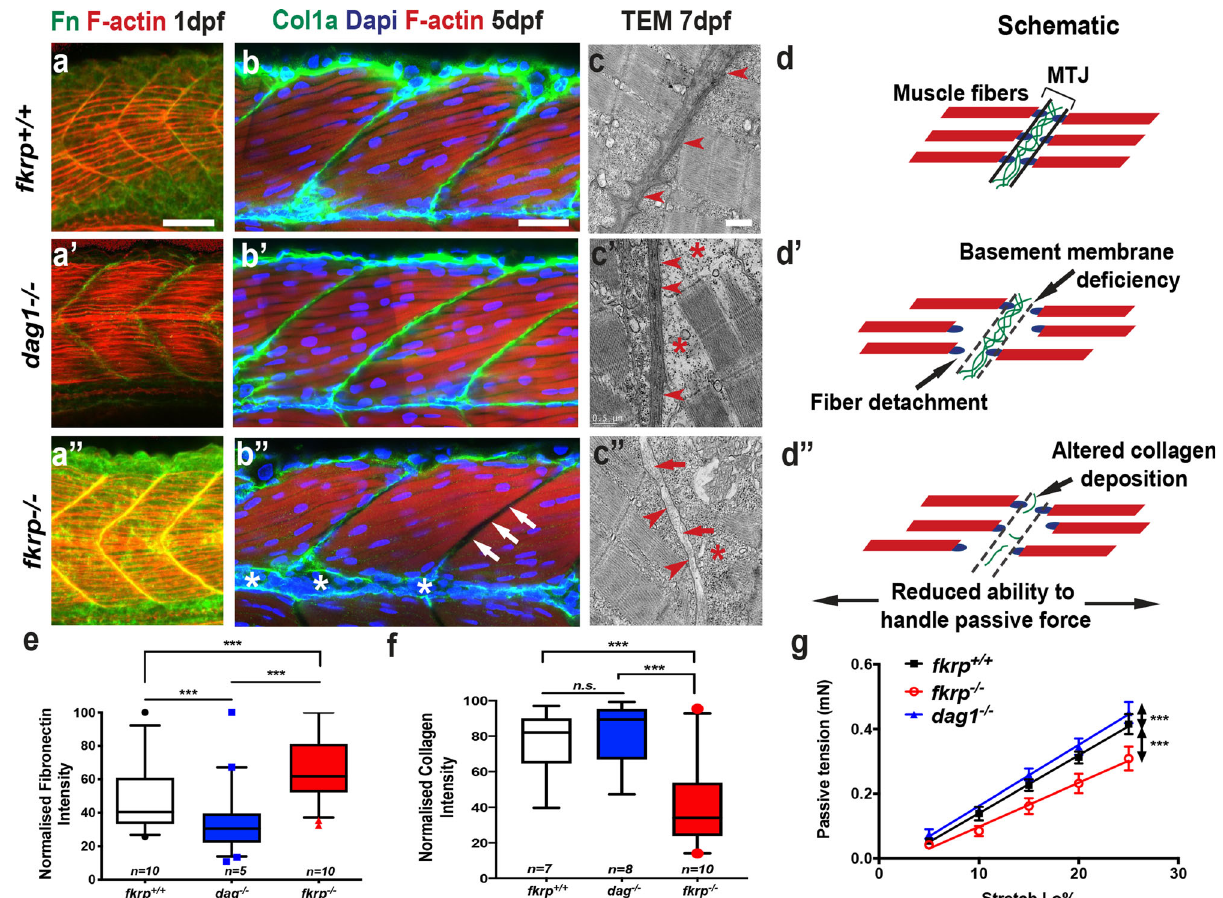
Fig. 2 The fi bronectin – collagen axis is disrupted at the muscle basement membrane in fkrp mutants. a – b ” Fibronectin and collagen immunochemistry. Whole-mount staining and confocal imaging of zebra fi sh myotomes centred on myotome 10 (1 dpf) and myotome 12 (5 dpf). Images are z projections of the mediolateral extent of the myotome stained for f-actin (red) to mark muscle fi bres and DAPI (blue) for nuclei. a Fibronectin (Fn) staining (green) at the vertical myosepta at 1 dpf, images representative of n = 9, three larvae from three separate clutches on different weeks, most severe and weakest phenotypes excluded (scale bar = 30 μ m). a ’ dag1 − / − , a ” fkrp − / − . b Collagen-1 (Col1a, green) staining of the muscle basement membrane in wild-type sibling fi sh. b ’ dag1 − / − and b ” fkrp − / − , white arrow: absent collagen, scale bar = 40 μ m. a – b ” Lateral views anterior to the left. c Transmission electron micrographs (TEM) of longitudinal sections of 7 dpf zebra fi sh myotome centred on the muscle basement membrane (red arrowheads). Red arrows: absent collagen fi brils, red star: fi bre detachment from vertical myosepta, scale bar = 0.5 μ m. Wild-type siblings, c ’ , dag1 − / − c ” , fkrp − / − , micrographs representative of ( n = 9), three larvae from three separate clutches on different weeks, most severe and weakest phenotypes excluded. d Schematic of fi bre-crossing and detachment model at the Myotendinous Junction (MTJ) and disease progression, d ’ canonical DGC axis in dag1 − / − and, d ” combined detachment crossing in fkrp − / − . e , f Measurement of max intensity from fi bronectin ( e ) and collagen ( f ) staining analysed by two-way ANOVA, ***( P = <0.0001), plotted points outside 95% con fi dence interval, box represents 5 – 95%, median centre line, whiskers = SEM, Tukey ’ s multiple comparison analysis, three independent experiments. g Passive force measurement at 6 dpf, calculated by plotting the maximum active force at given loads, as passive tension (mN) against external stretch (Lo%), with representative linear regression analysis of the plotted points of fkrp + / + sibling (sib); black line ( n = 8), fkrp − / − , red line ( n = 6) and dag1 − / − blue line ( n = 5) was used to test the signi fi cance of the differences (*** P = <0.0001), error bars = SEM.